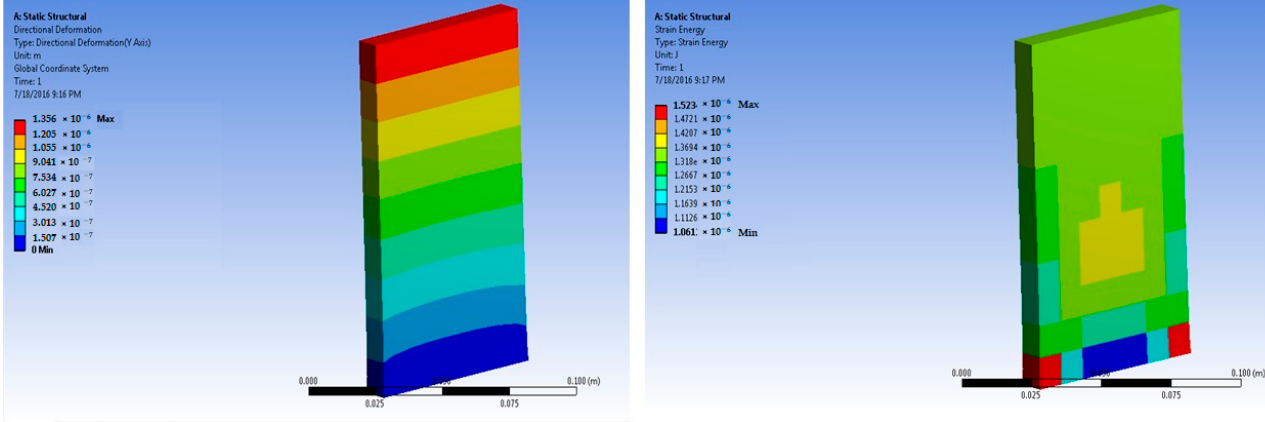
× 10 5 N force (deformation and